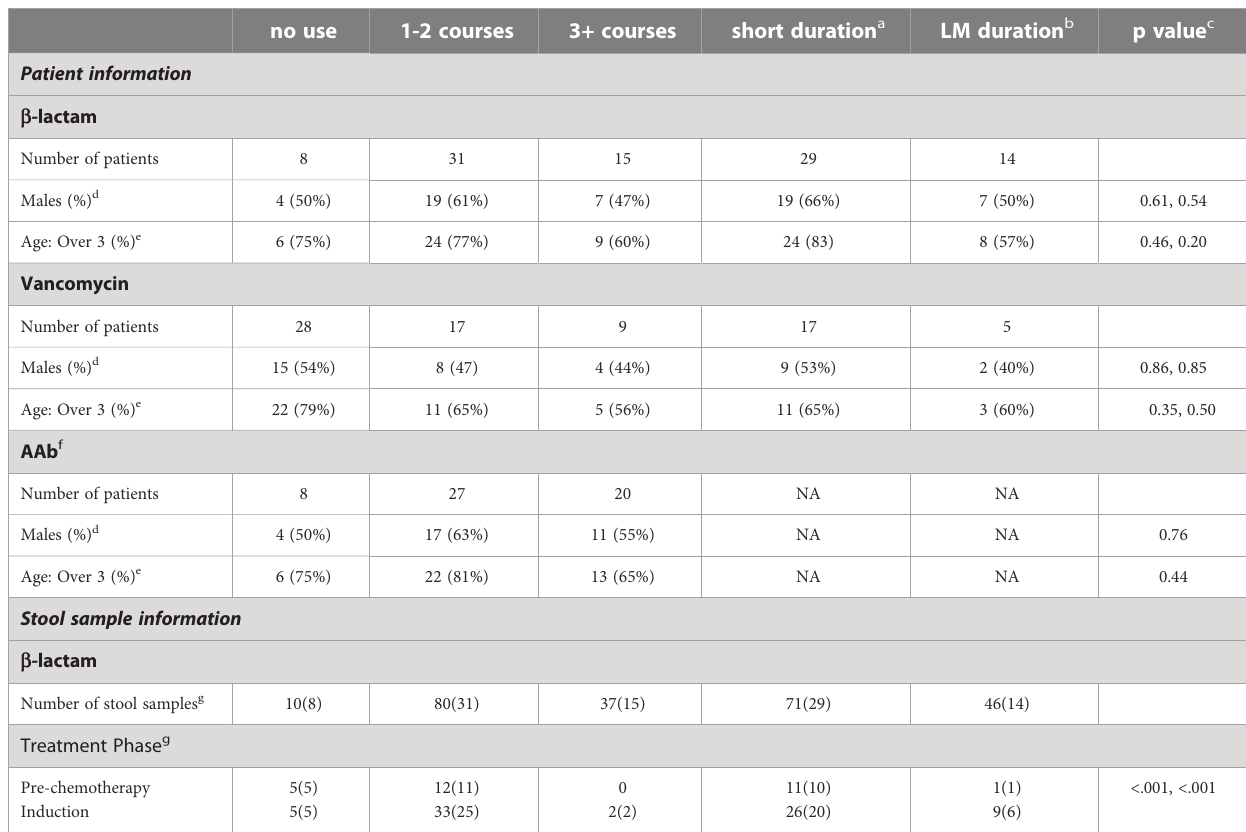
TABLE 1 Patient and stool sample